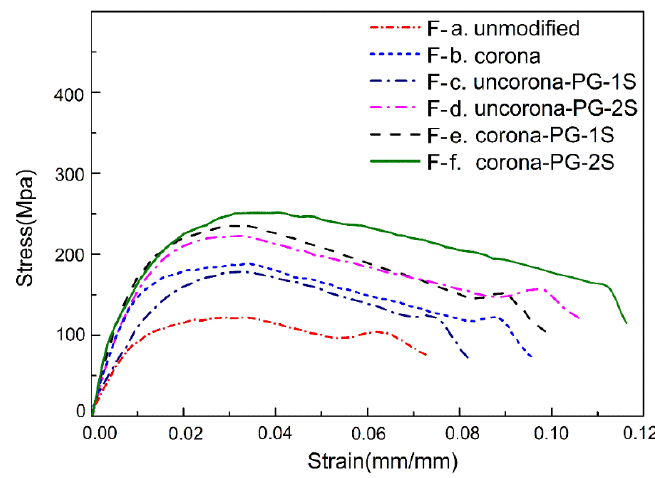
Figure 6. Typical stress–strain curve of the composite of surface treatment methods.